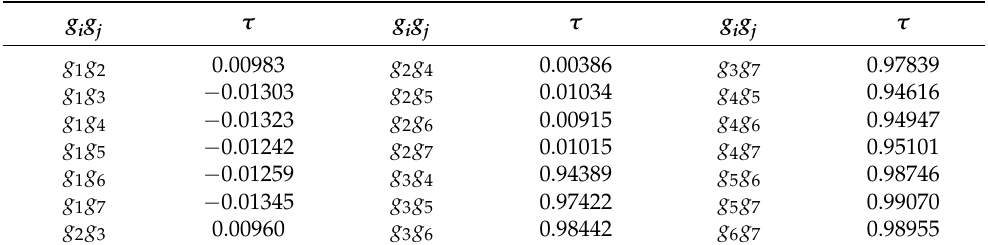
Table 4. Calculations of Kendall rank correlation coefficients for each combination of failure